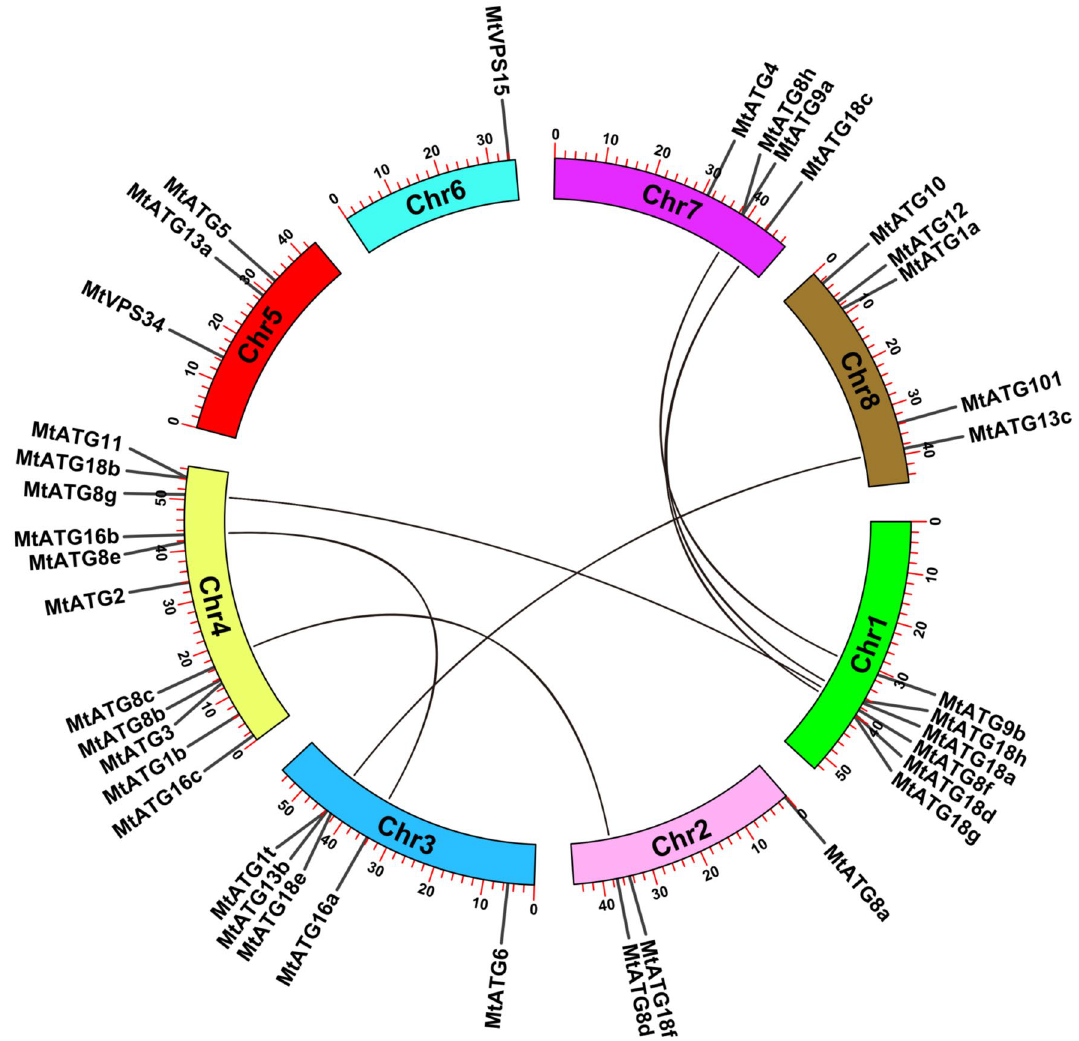
Figure 1. Chromosomal distribution and gene duplication of MtATGs . The genome locations of MtATGs were retrieved from the M. truncatula genome annotation (MedtrA17_4.0) except for MtATG7. The duplications between MtATGs were analyzed by the MCScanX program and linked with black